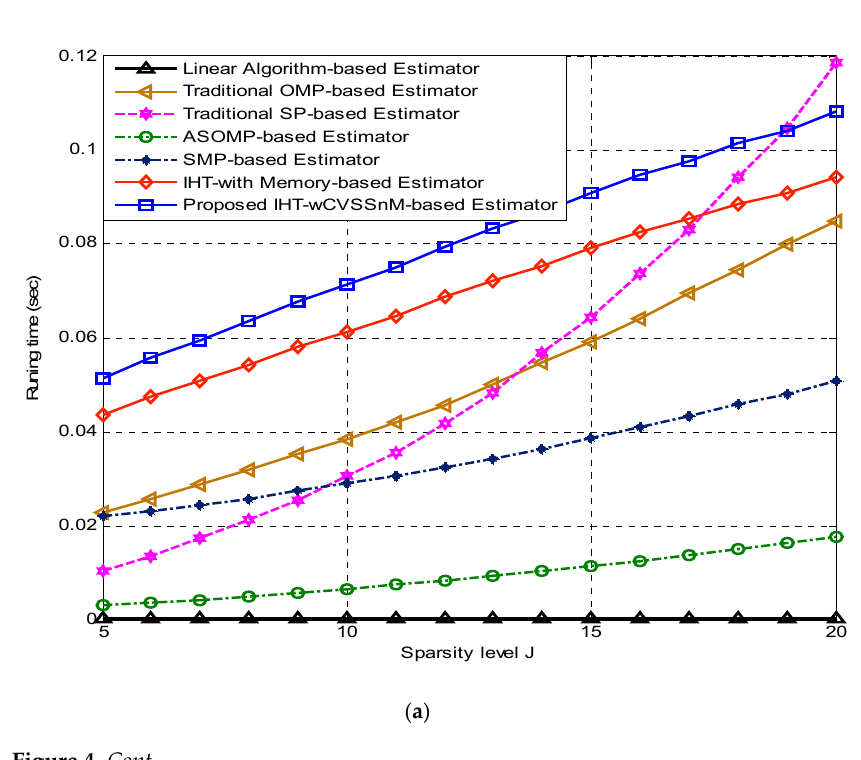
Figure 3. Achievable comparative MSE versus temporal correlation degree of dynamic sparse channel performance of the proposed IHT-wCVSSnM-based estimator with other channel estimators ( a ) SNR = 5 dB, ( b ) SNR = 15 dB.